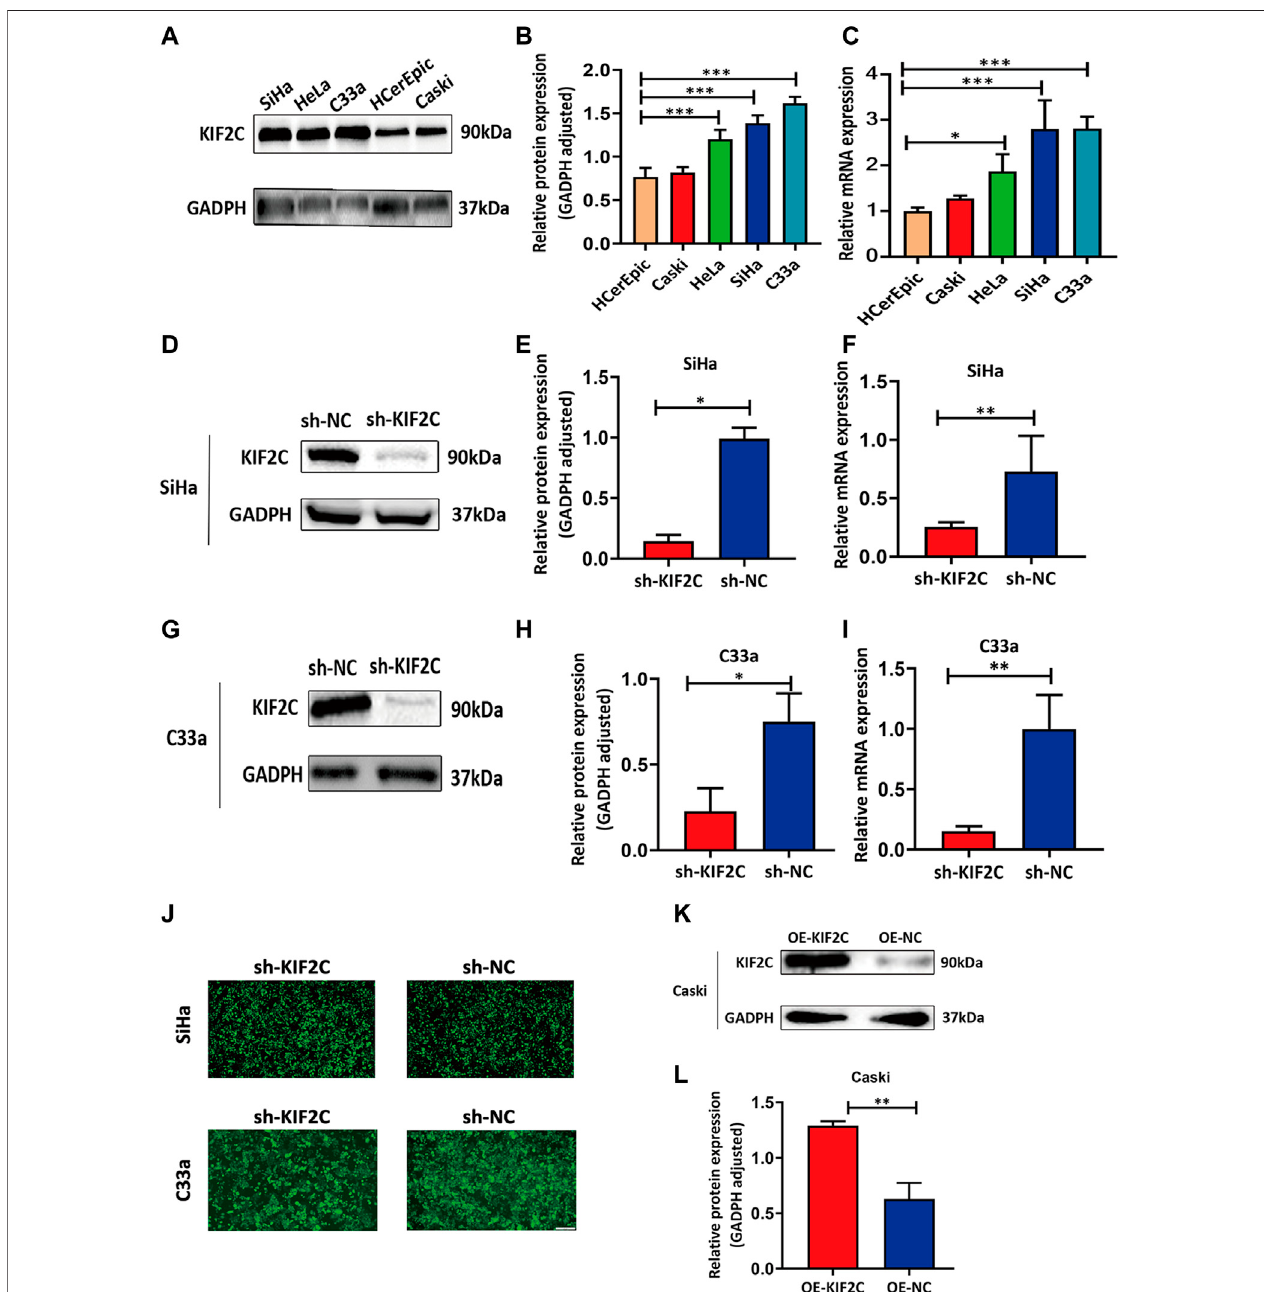
FIGURE 6 | Establishment of KIF2C knockdown and overexpression cell lines using cervical cancer cell lines. (A) Gray value of KIF2C protein band in SiHa, HeLa, Caski, C33a and HCerEpic; (B) relative protein expression of KIF2C in SiHa, HeLa, Caski, C33a, and HCerEpic; (C) relative mRNA expression of KIF2C in SiHa, HeLa, Caski, C33a, and HCerEpic; (D) gray value of KIF2C protein band in SiHa after transfection; (E) relative protein expression ofKIF2C in SiHa after transfection; (F) relative mRNA expression of KIF2C in SiHa after transfection; gray value, protein and relative mRNA expression of KIF2C in C33a after transfection are shown in Figures 5G – I ; (J) green fl uorescence indicated a transfection ef fi ciency greater than 80%; (K) gray value of KIF2C protein band in Caski after transfecting KIF2C overexpressed plasmid; (L) relative protein expression of KIF2C in Caski after transfecting overexpressed plasmid. * p < 0.05; ** p < 0.01; *** p < 0.001.